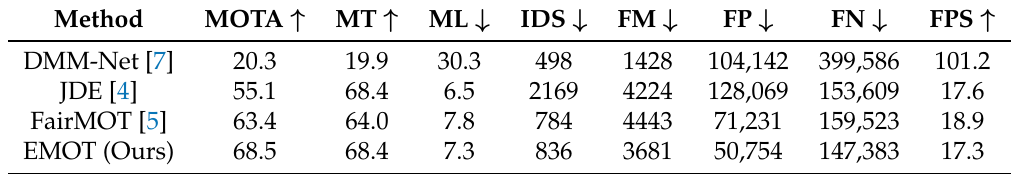
Table 3. MOT results of our single-shot MOT system and different trackers, which are evaluated on the UA-DETRAC-test set using the CLEAR MOT metrics. All inference speeds are measured with a single Nvidia Geforce RTX 2080 SUPER GPU. The ↑ indicates that a higher score is better, while ↓ indicates that a lower score is